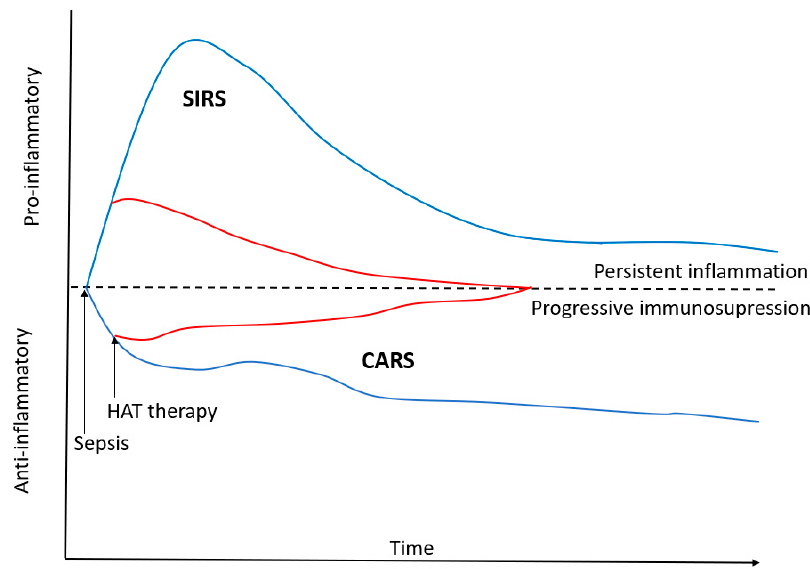
Figure 2. Treatment with Hydrocortisone, vitamin C and Thiamine attenuates both the pro- and anti-inflammatory response in patients with sepsis. HAT-hydrocortisone, ascorbic acid and thiamine; SIRS—Systemic Inflammatory Response Syndrome; CARS—Compensatory Anti-inflammatory Response